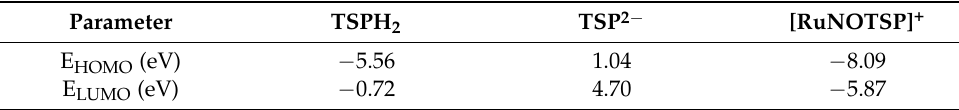
Table 2. Quantum parameters for TSP-H 2 ; TSP 2 − , anion and [RuNOTSP] +